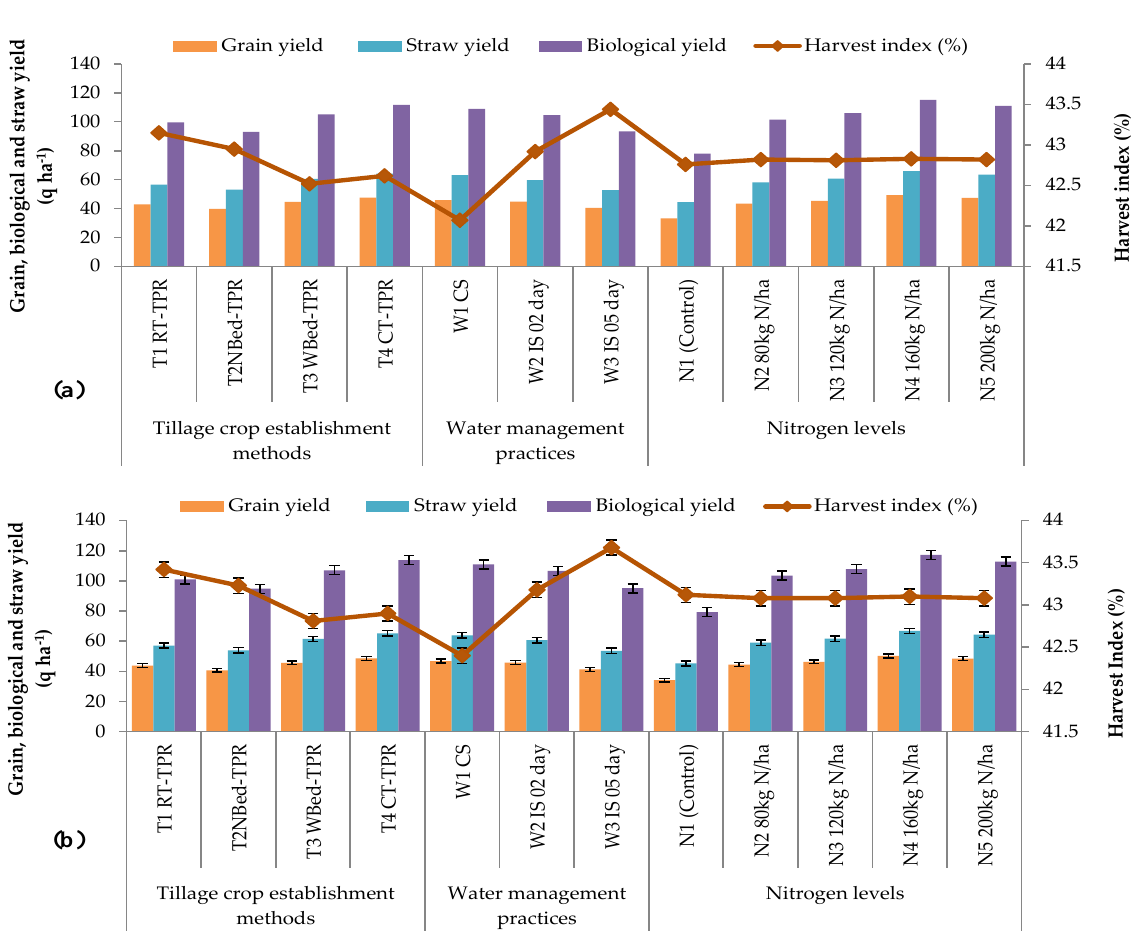
Figure 6. Interactive effects of tillage, water and nitrogen on grain, biological and straw yield, and harvest index (%) of rice in both years: ( a ) 2016 and ( b ) 2017.